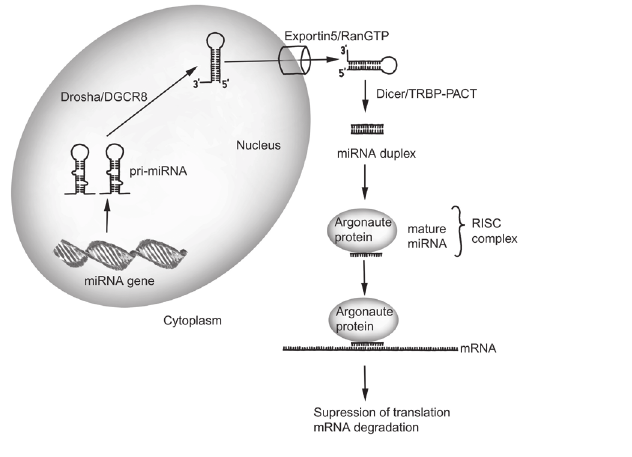
Figure 1. Biosynthesis and mechanism of action of miRNA (Abbreviations: DGCR8: DiGeorge Syndrome Critical Region Gene 8, pri-miRNA: primary miRNA, TRBP: Transactivation Response Element RNA-Binding Protein, RISC: RNA-Induced Silencing